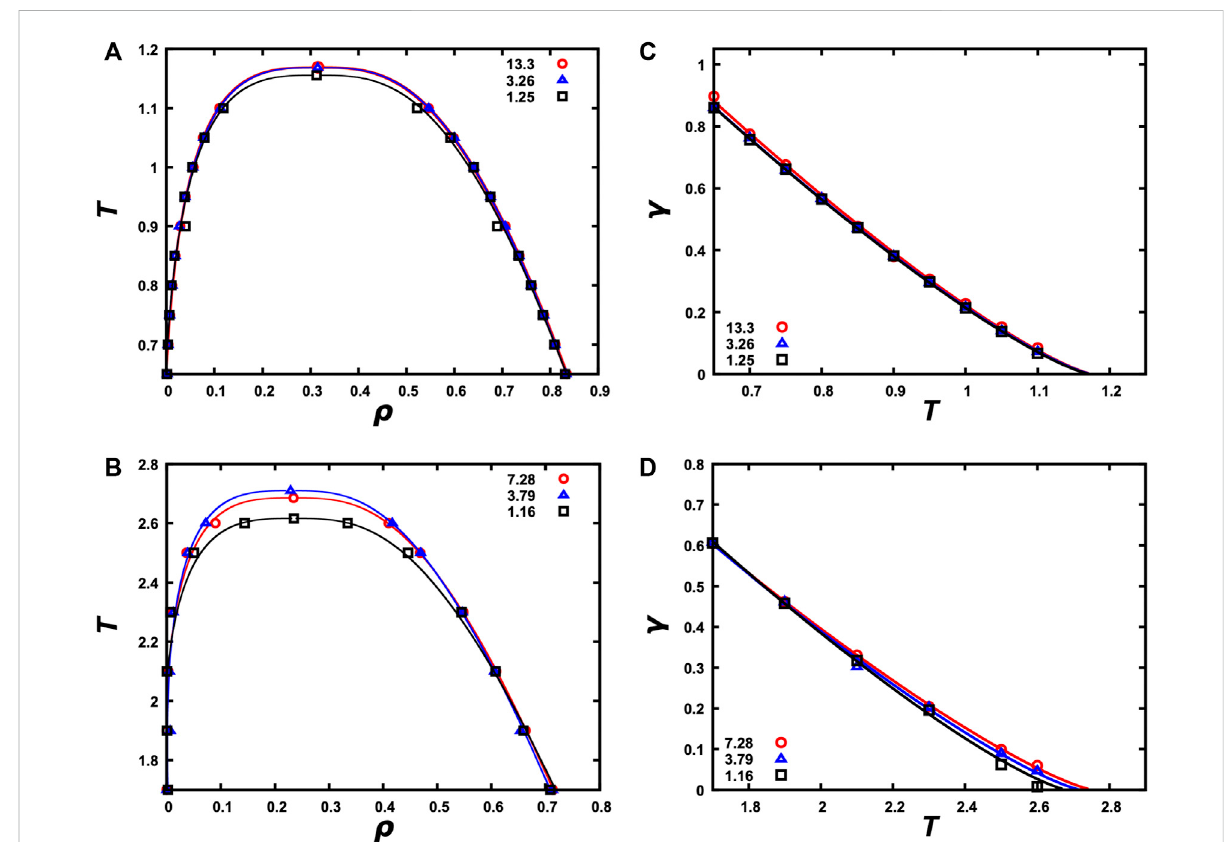
FIGURE 5 Binodalsandinterfacialtensionscalculatedfromsnapshotswithasingleslab. (A) BinodalsoftheLJparticlesystemat N =4,000and L z / L x =1.25, 3.26, and 13.3. (B) Binodals of the LJ chain system at N = 4,000 and L z / L x = 1.16, 3.79, and 7.28. (C) Interfacial tension versus temperature for the LJ particle system at the three L z / L x ratios. (D) Interfacial tension versus temperature for LJ chain system at the three L z / L x